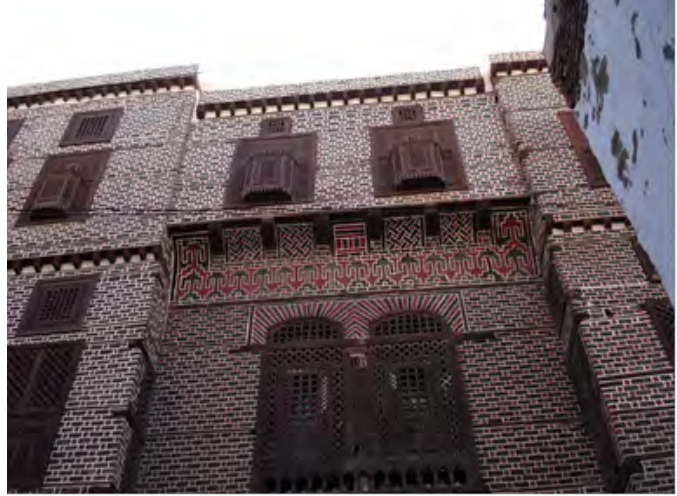
Figure 8. (ArabKelly House - National Museum of